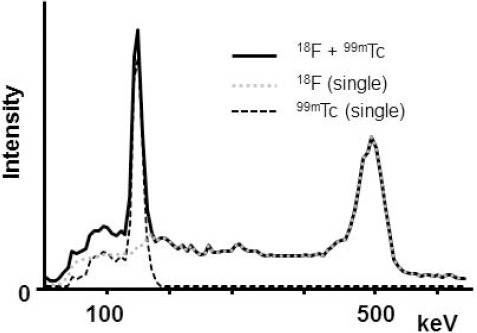
The energy spectra of 18F and 99mTc by Infinia 8. The intensity was similar to that of the clinical study